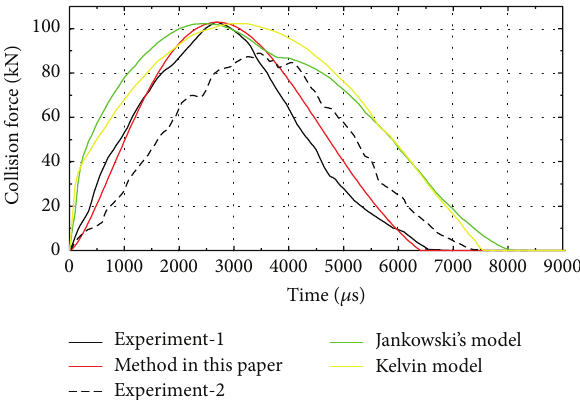
Figure 9: Collision force-time histories of concrete-to-concrete (velocity